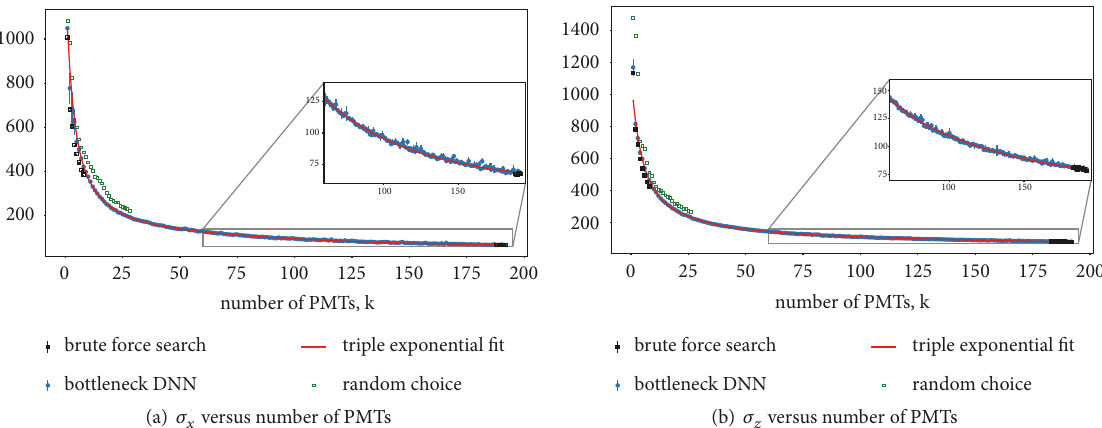
Figure 7: Residual curves for 𝑥 (a) and 𝑧 (b) as a function of the number of PMTs used in the reconstruction. The results plotted as solid squares are those from the brute force search. An empirical fit to the bottleneck DNN results was done with a triple exponential. Resolutions from random choice of PMTs are shown as empty squares. A zoom-in on the residual curves is also shown in the